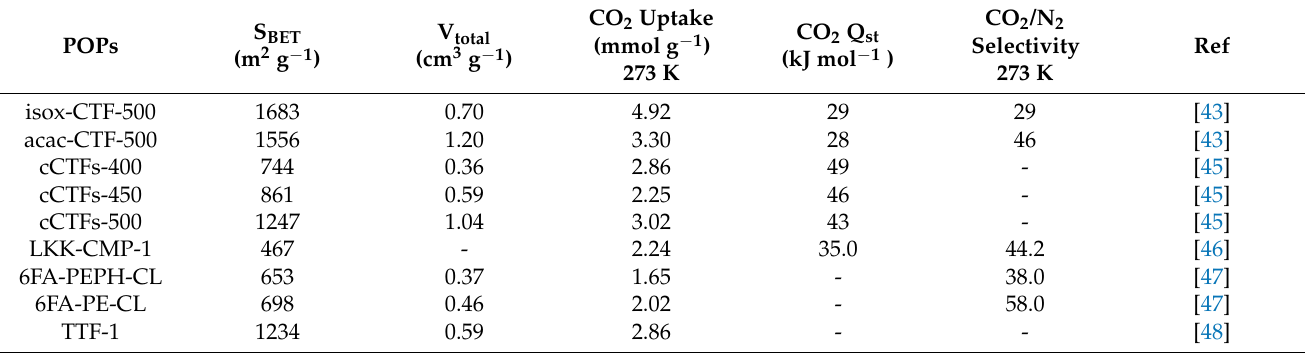
Table 2. The textural features and CO 2 adsorption characteristics of reported